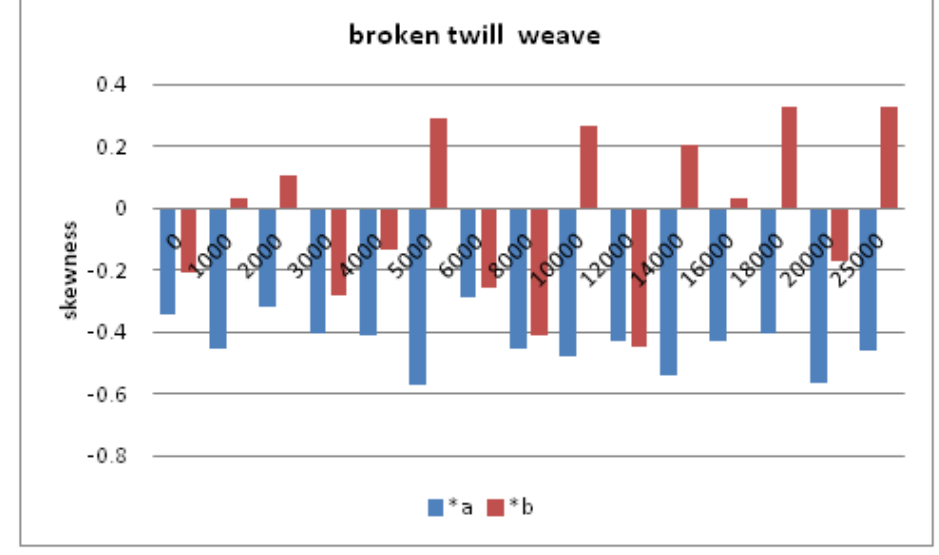
Figure 8. Skewness graph—Fabric